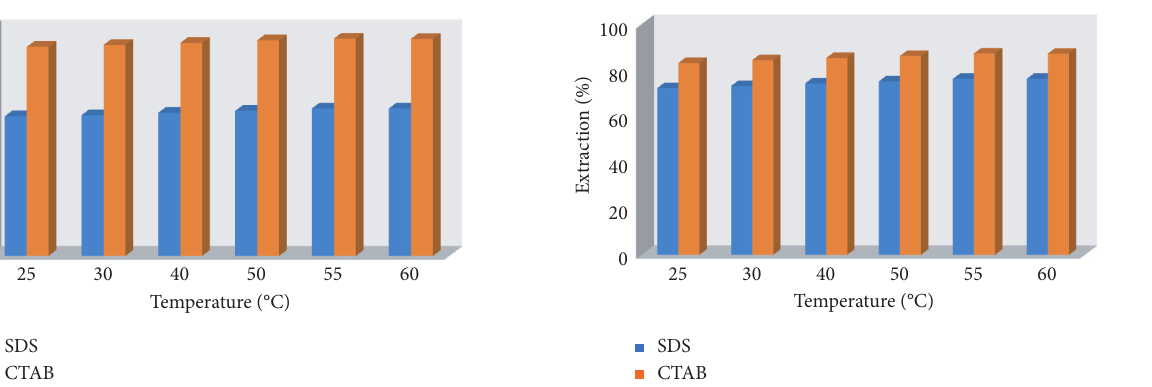
Figure 12: Effects of the temperature on extraction% of RB222 at concentration 6 × 10 − 5 mol/10 ml (contact time: 60min), surfactant concentration 9 × 10 − 2 mol/10 ml, and solution pH 7.2 for CTAB and pH 4.2 for